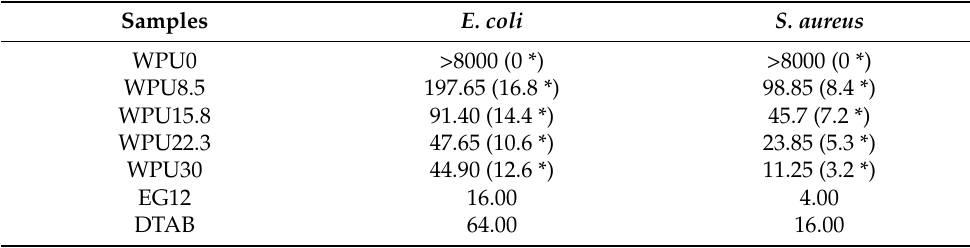
Table 2. MICs of WPUn emulsions, EG12, and DTAB ( µ g · mL − 1